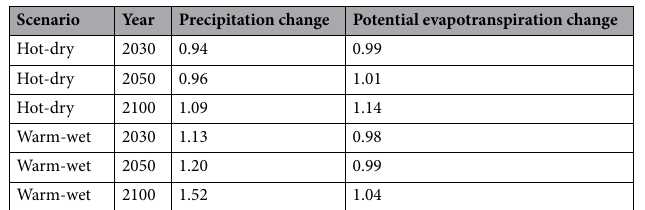
Table 1. Two projected climate change scenarios, with the changed climate values in 2030, 2050 and